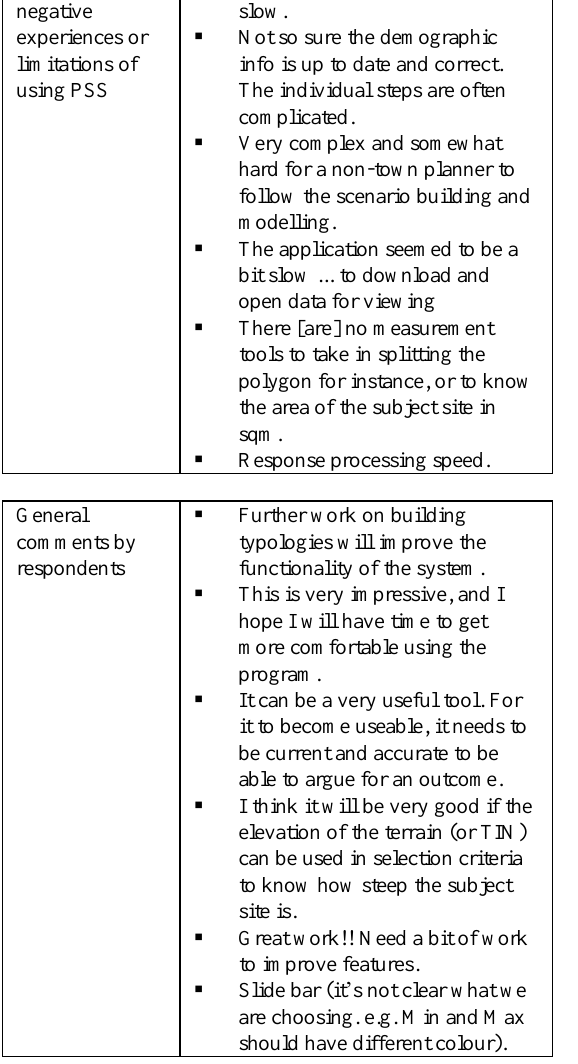
Table 2. PSS qualitative data based on the online